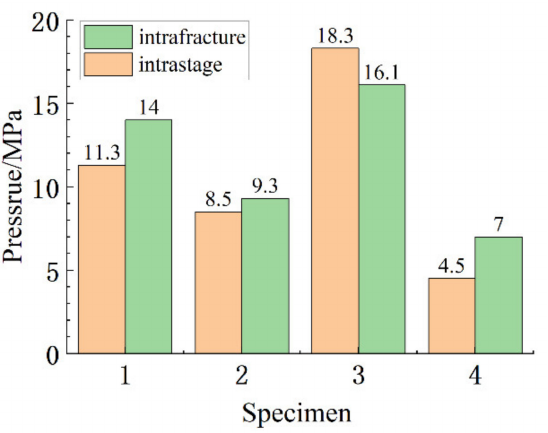
Figure 7. Relationship between particle size combination of the temporary plugging agent and peak pressure of intrafracture and intrastage temporary plugging fracturing.